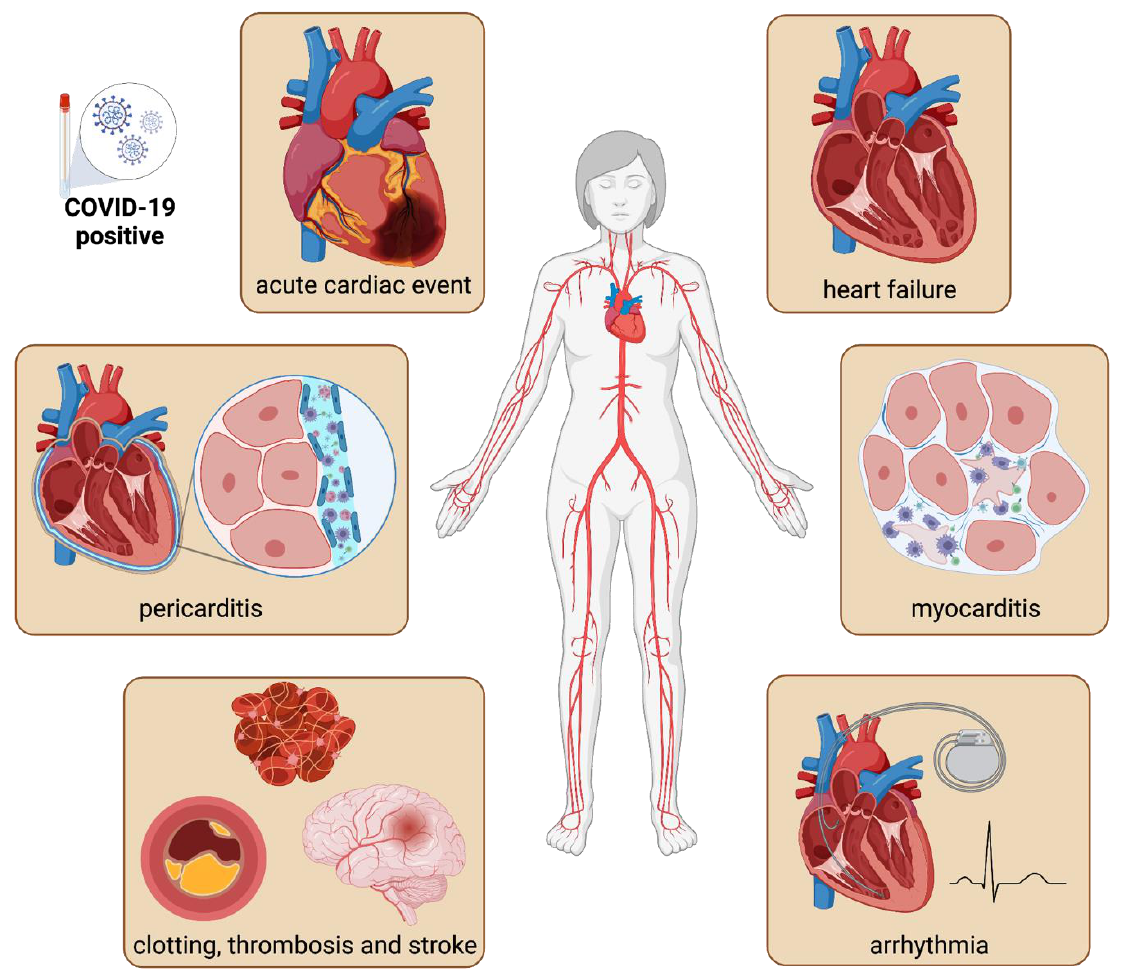
Figure 1. The cardiac complications of COVID-19. Cardiac involvement during the clinical course of COVID-19 can manifest as acute myocardial injury with elevated troponin, heart failure with a decreased ejection fraction, myocarditis, cardiac arrhythmia, thromboembolic events and pericardi- tis. Evidence of cardiac inflammation can also be present in people who seemingly recover from acute illness.